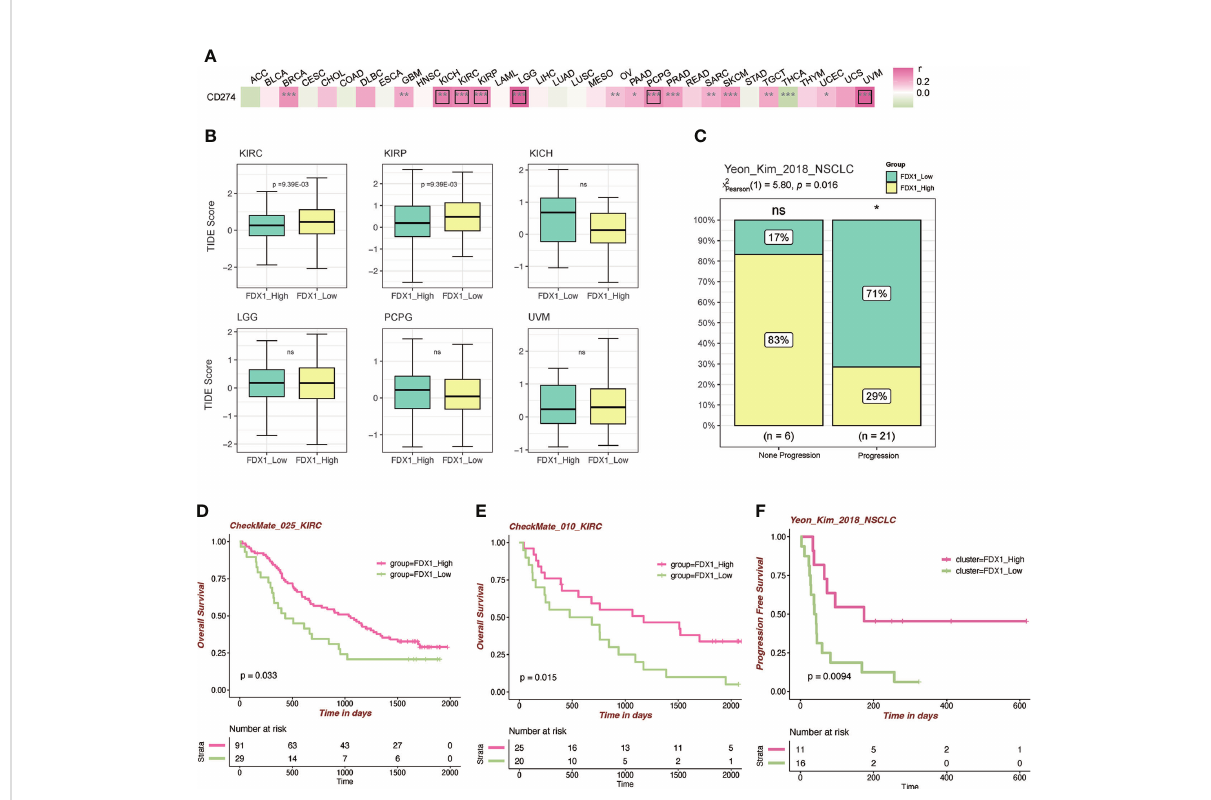
FIGURE 6 Immunotherapy-related analysis of FDX1. (A) Correlation between FDX1 and CD274 (PD-L1) in the TCGA tumor cohorts. The black box means r > 0.3 and p < 0.05. (B) The TIDE scores between the high- and low- FDX1 groups in the tumors. (C) The distribution between immunotherapy progression and FDX1 expression. (D – F) The Kaplan – Meier plot of patients under immunotherapy between the high and low FDX1 expression groups. ns p ≥ 0.05, *p < 0.05, **p< 0.01, ***p <